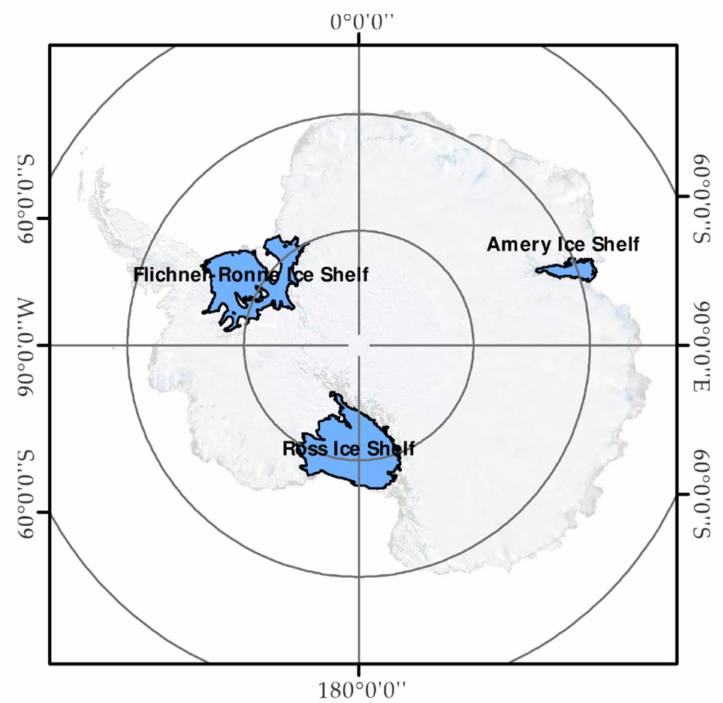
Figure 1. Locations of Ross ice shelf (RIS), Filchner–Ronne ice shelf (FRIS), and Amery ice shelf (AIS). The backgrounding map is the Landsat Image Mosaic of Antarctica (LIMA)